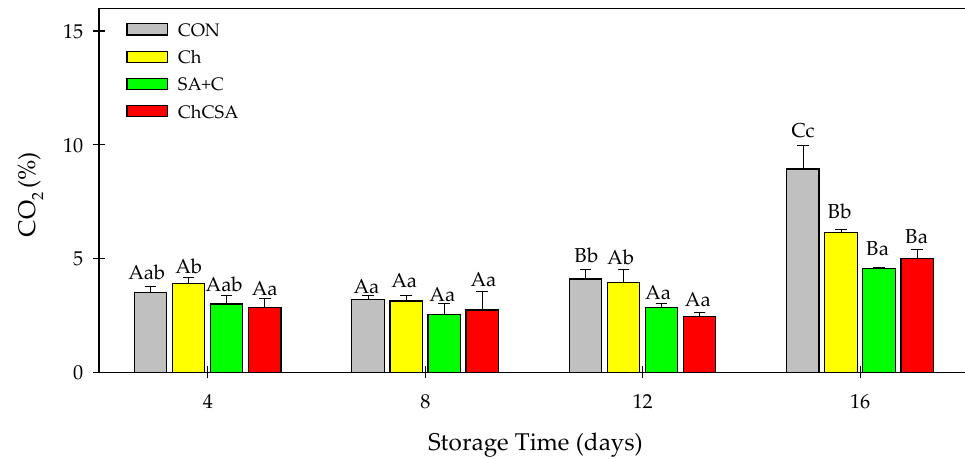
Figure 6. The effect of layer-by-layer and single-layer coatings on the percentage of carbon dioxide gas